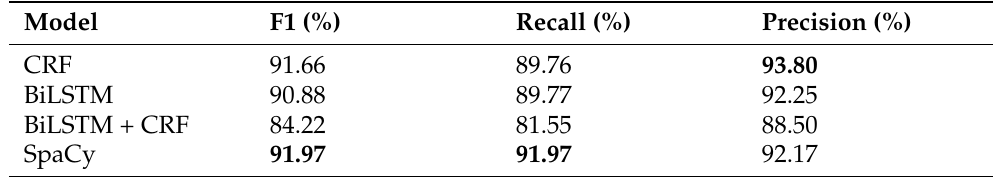
Table 9. Performance of the proposed models (Best F1 score).